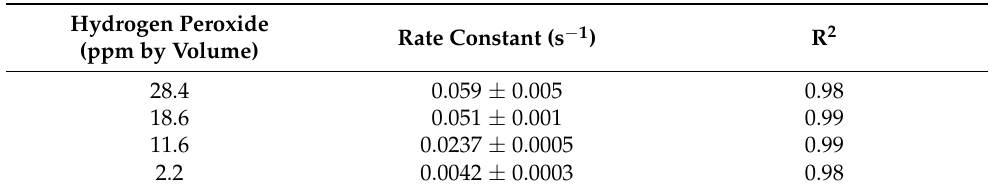
Table 1. The phenomenological first-order rate constants and error bars determined at different hydrogen peroxide ppm.